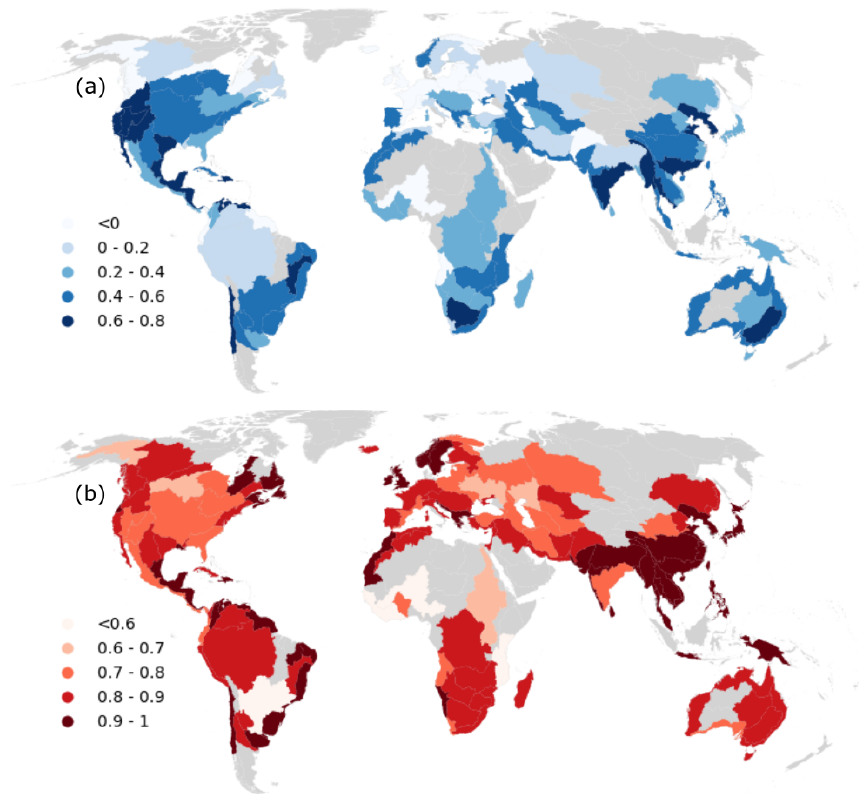
Figure 9. The correlations of annual storage changes and reservoir inflow (as approximated by basin-modeled streamflow) (a) and reservoir inflow and precipitation (b) in each